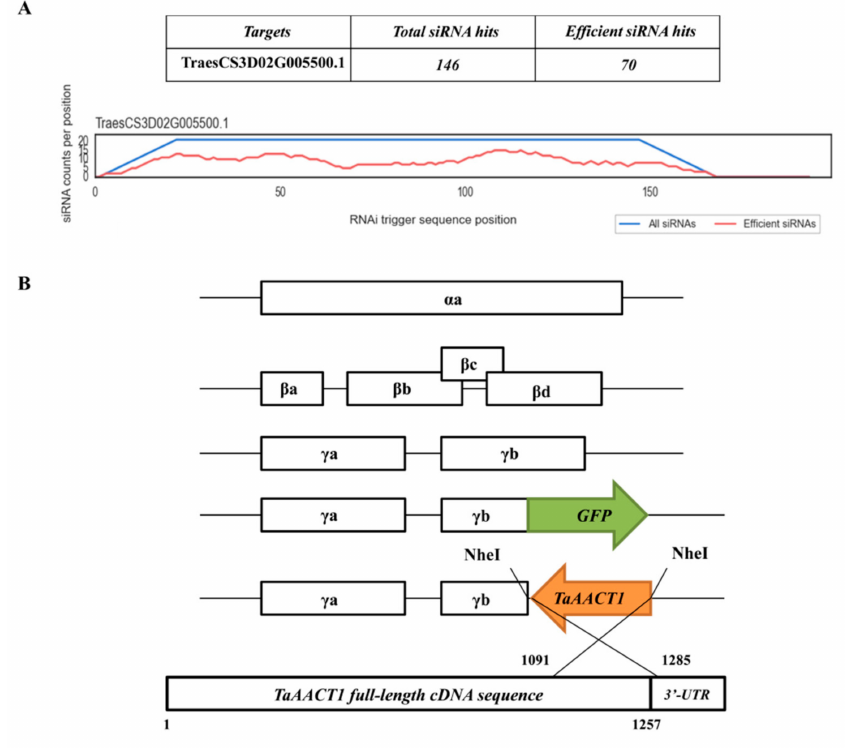
Figure 4. ( A ) Si-Fi software off-target prediction results. ( B ) Scheme of genomic RNAs of the BSMV and the recombinant virus construct BSMV: TaAACT1 . The antisense orientation of the TaAACT1 insert is indicated by orange